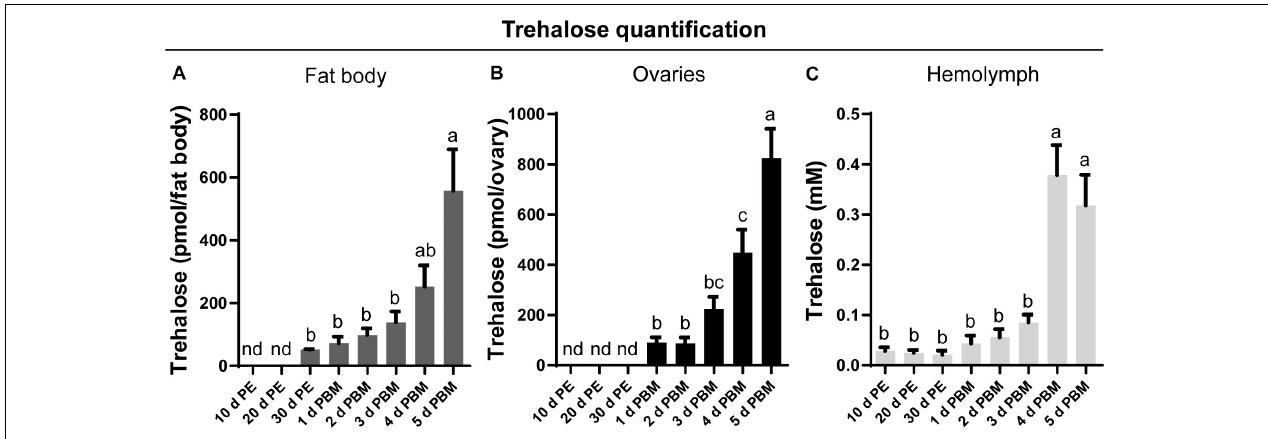
FIGURE 1 | Trehalose content in the fat body, ovary, and hemolymph of unfed and fed R. prolixus females. The trehalose content of fat body (A) , ovaries (B), and hemolymph (C) was quantified in unfed adult females [10, 20, and 30 days post-ecdysis (PE)] and in fed adult females at 1, 2, 3, 4, and 5 days post blood meal (PBM). Trehalose content increases significantly in both tissues and hemolymph following a blood-meal. The results are shown as the mean ± SEM ( n = 6, where each n represents an individual tissue from 1 insect or a hemolymph pool from 2 to 3 insects). Statistically significant differences were determined by a one-way ANOVA and a Tukey’s test as the post hoc test. Different letters indicate significant difference at P < 0.05. nd, not detected.